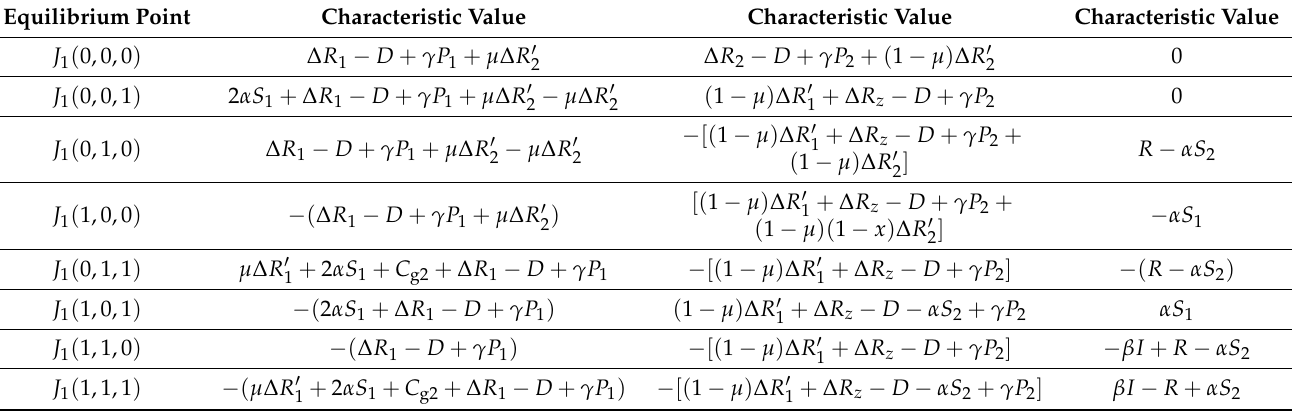
Table 5. Jacobian